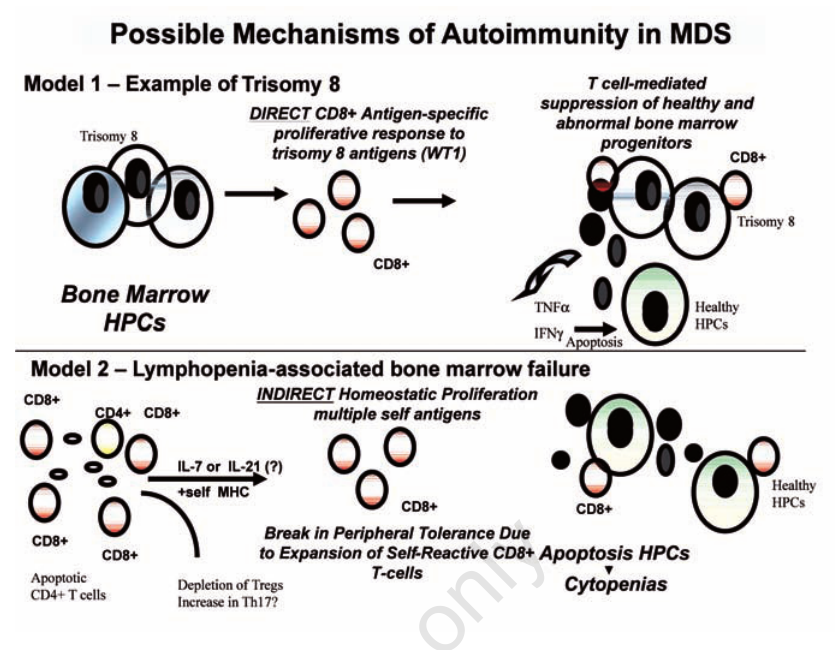
Figure 1. Molecular model of T-cell pathogenesis in MDS. Described in this review are the supporting data that link T-cell abnormalities to multiple abnormal events that include apoptotic response and the presence of inflammation in the bone marrow microenviron- ment. The mechanism controlling the expansion of self-reactive CD8 + T-cells appears to be two fold described by two models (DIRECT and INDIRECT); 1) there may be direct activation of CD8 + T cells in response to abnormally expressed bone marrow antigens as exemplified by patients with trisomy 8, and 2) there may be expansion of destructive CD8 T cells due to homeostatic cytokines of the IL-2R βγ common cytokines which include IL- 7, IL-2, IL-15, and IL-21. From previous results, lymphopenia-associated autoimmunity has been linked to antigen-specific CD8 + T cells with variable self- antigen reactivity. Survival advantage and clonal expansion dominates from CD8 + self-reactive T cells that respond to antigen in the context of self-MHC class I bypassing peripheral tolerance mechanisms. Results suggest that self-reactive CD8 + T-cells are involved in the suppres- sion of bone marrow progenitors through direct cytotoxicity of the MDS clones such as trisomy 8 + HPCs or the release of cytokines such as TNF α and IFN γ . There is also evi- dence that depletion of CD4 + regulatory T cells (Tregs) and accumulation of IL-17-secret- ing CD4 + T cells (Th17) may be imbalanced. Evidence supports the role of these T-cell abnormalities in cytopenias and increased apoptosis observed in lower-risk MDS. HPC=Hematopoietic Progenitor Cells, WT1=Wilms’ tumor 1